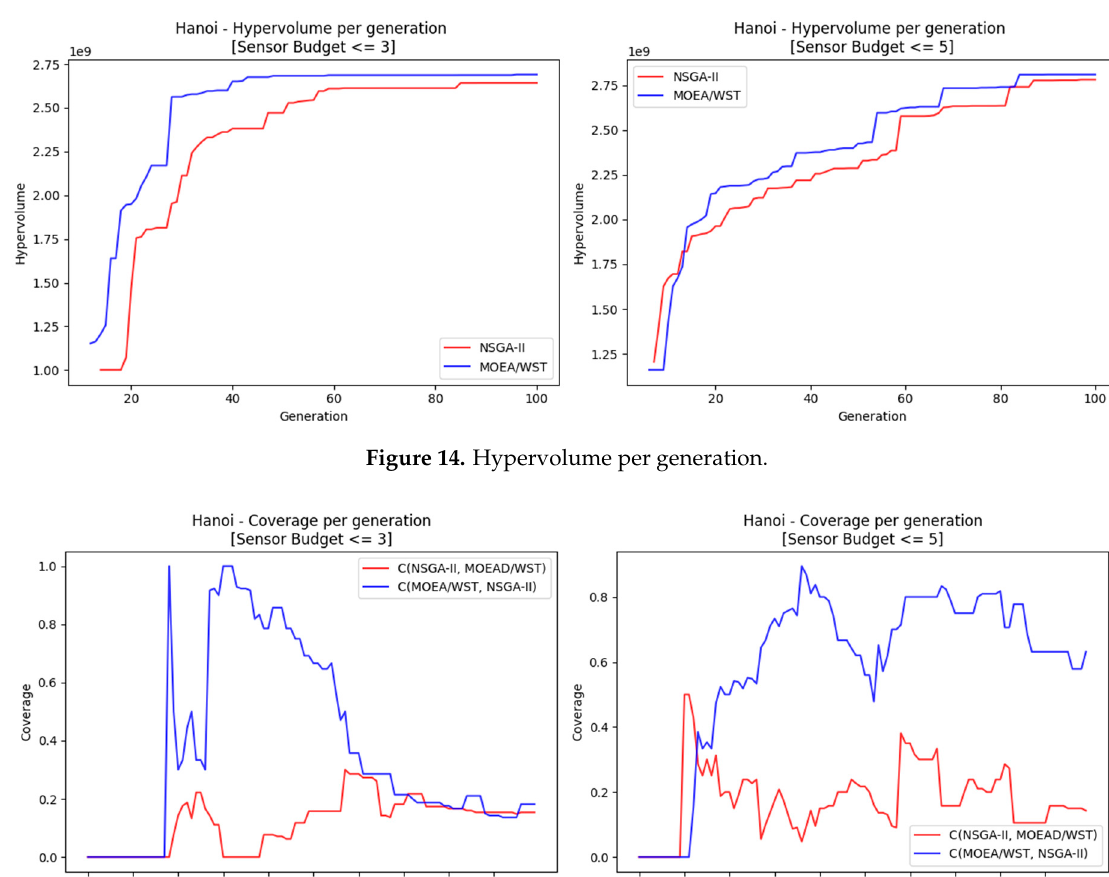
Figure 13. Detection time over the budget.